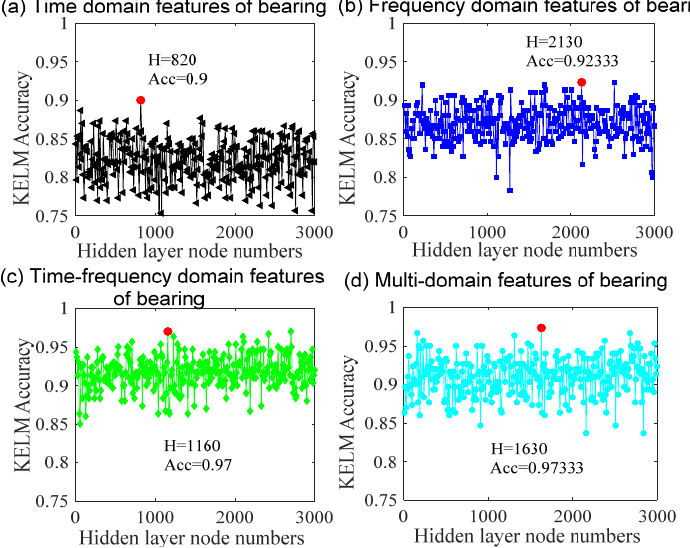
Figure 7. Diagnosis results for the time − domain, frequency − domain, time–frequency domain, and multi − domain features of the bearing with different hidden layers in KELM.